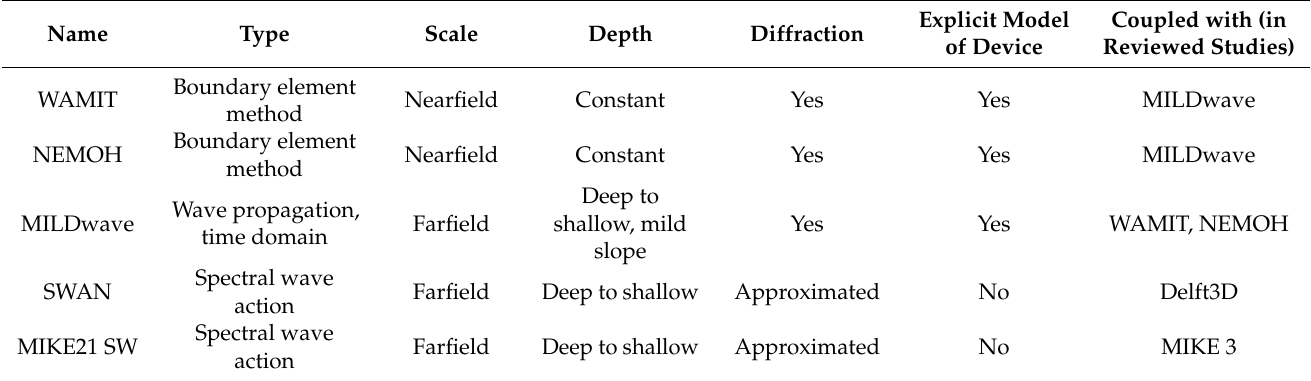
Table 1. Characteristics of models commonly used to evaluate the effects of marine energy devices on waves, including in reviewed studies. Nearfield is defined as within approximately 5 device diameters. This list is not